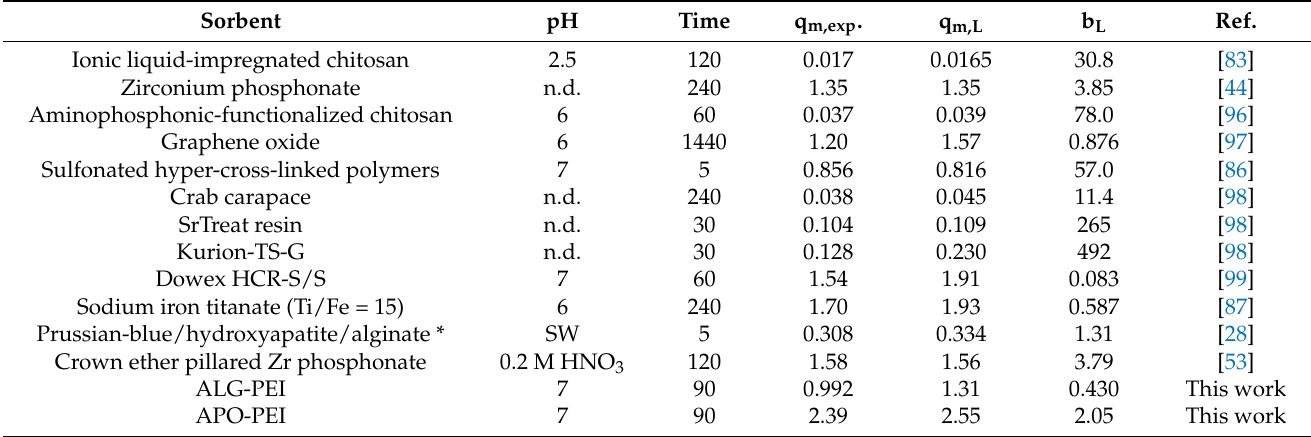
Table A6. Comparison of Sr(II) sorption properties with alternative sorbents.